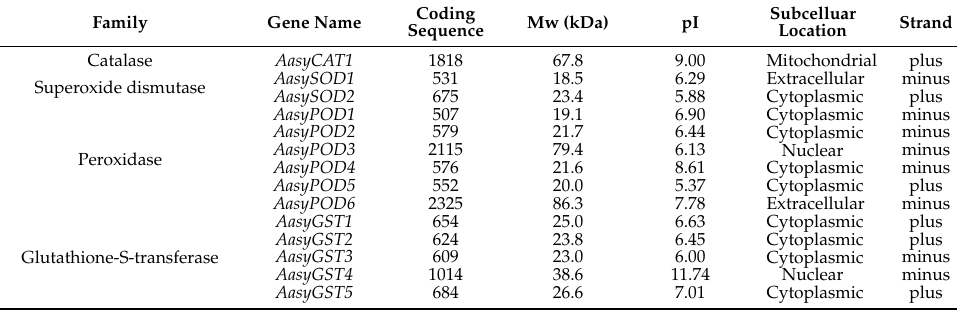
Table 2. Information on antioxidant enzyme genes in A. asychis